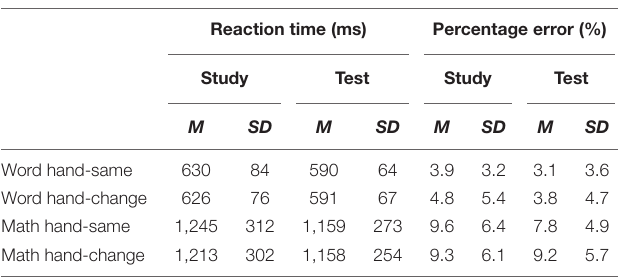
TABLE 3 | Means of median reaction times, expressed in milliseconds (ms), and percentage of errors (%) for the classification of words and equations in Experiment 2.